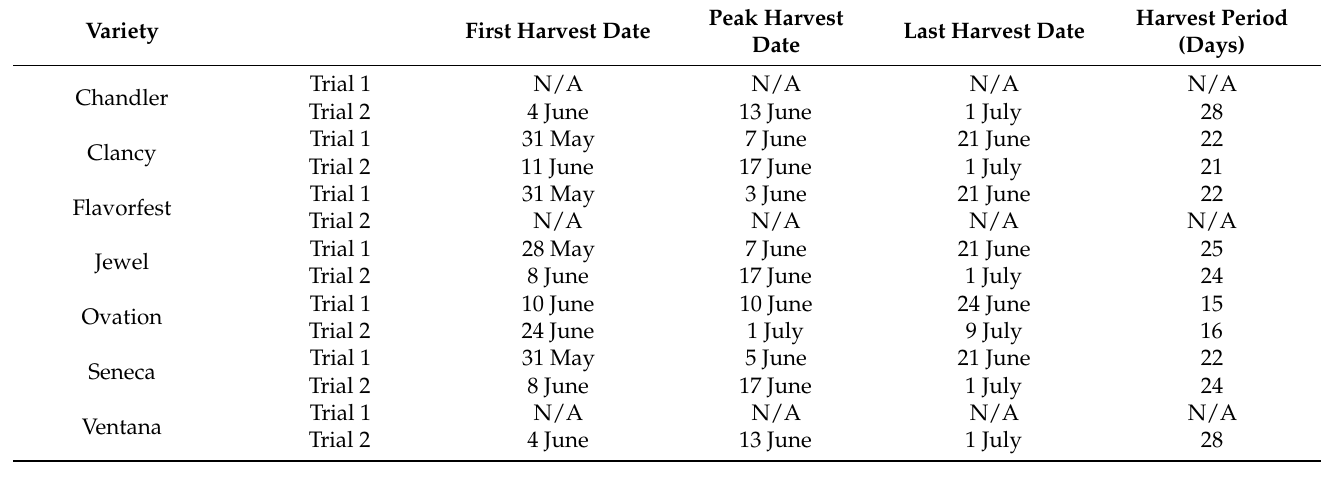
Table 1. First, peak and last harvest date and length of harvest for seven short-day strawberry varieties grown in annual plasticulture in a cold climate region (central NY) in consecutive trials harvested in 2013 and 2014. Peak harvest date is the date when the greatest fruit weight was harvested in a single daily harvest. ‘Flavorfest’ was only included in Trial 1, and ‘Chandler’ and ‘Ventana’ were only included in Trial 2.